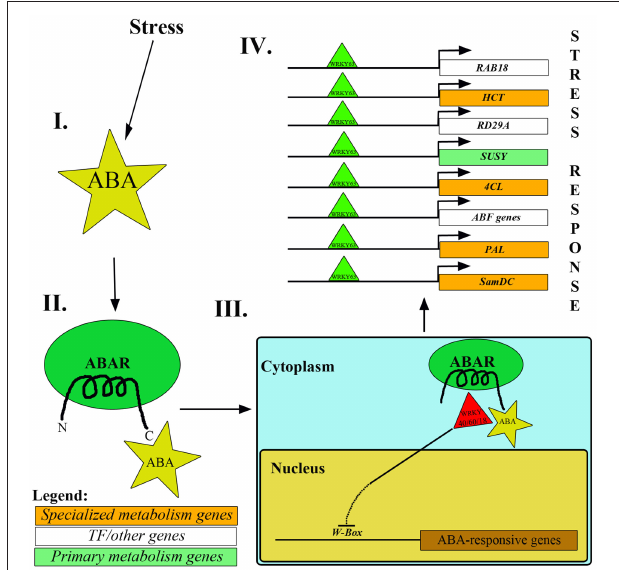
FIGURE 3 | Mechanism of repressor WRKYs removal from nucleus mediated by ABA. (I, II). Under stress conditions, ABA binds to the C-terminus of ABAR. (III) Consequently, it leads to the transport of At WRKY40/18/60 from the nucleus to the cytoplasm. (IV) Subsequently, At WRKY63 binds to the promoter regions of stress-responsive genes like RAB18, RD29A, HCT, SUSY, 4CL, PAL, SamDC and ABF genes, thereby enhancing their expression and mitigating